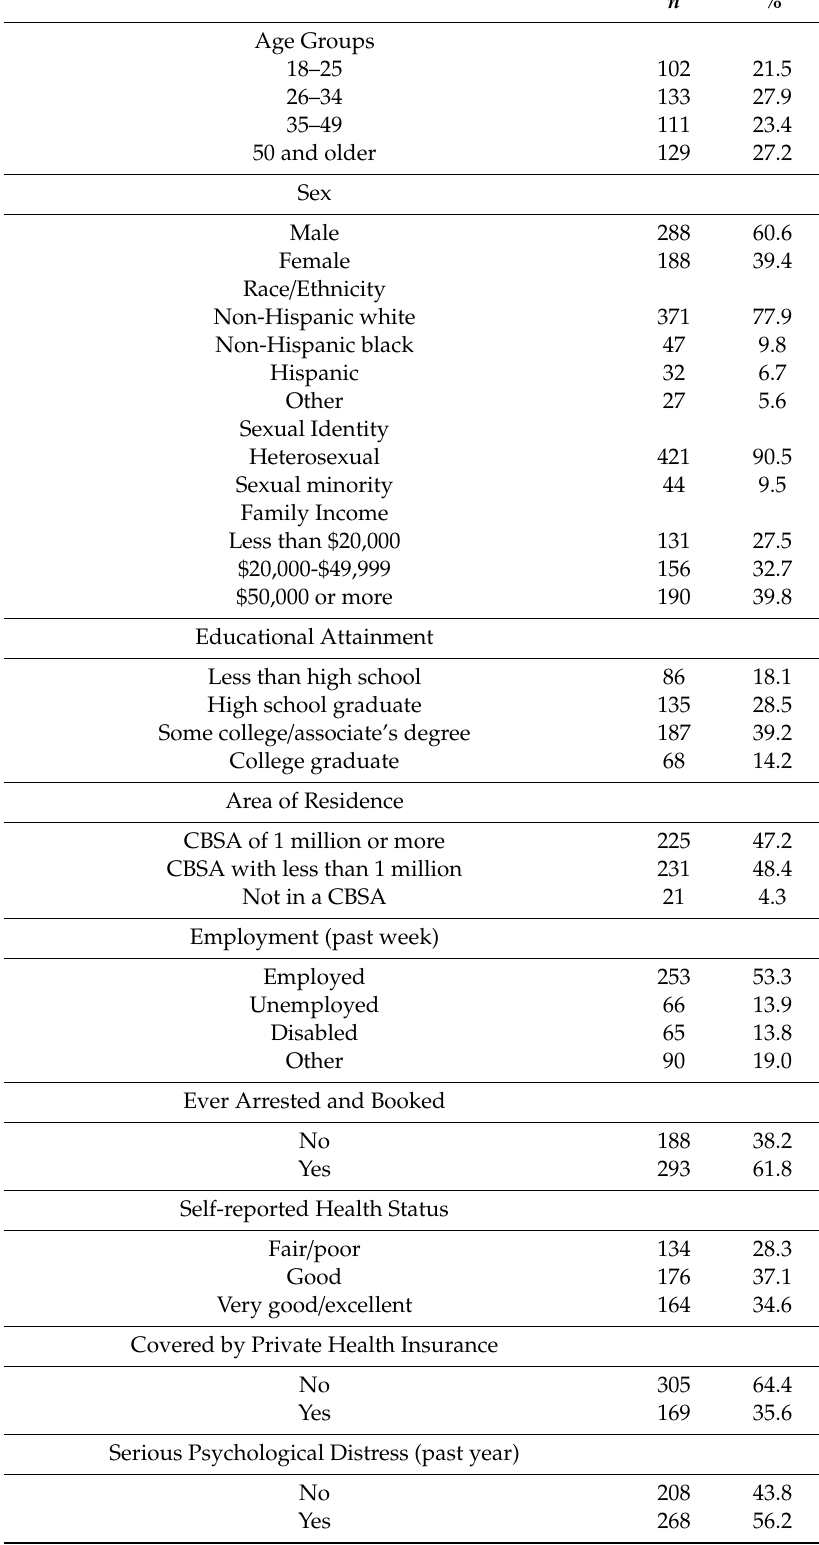
Table 1. Sample descriptive characteristics ( n = 476; Weighted n =